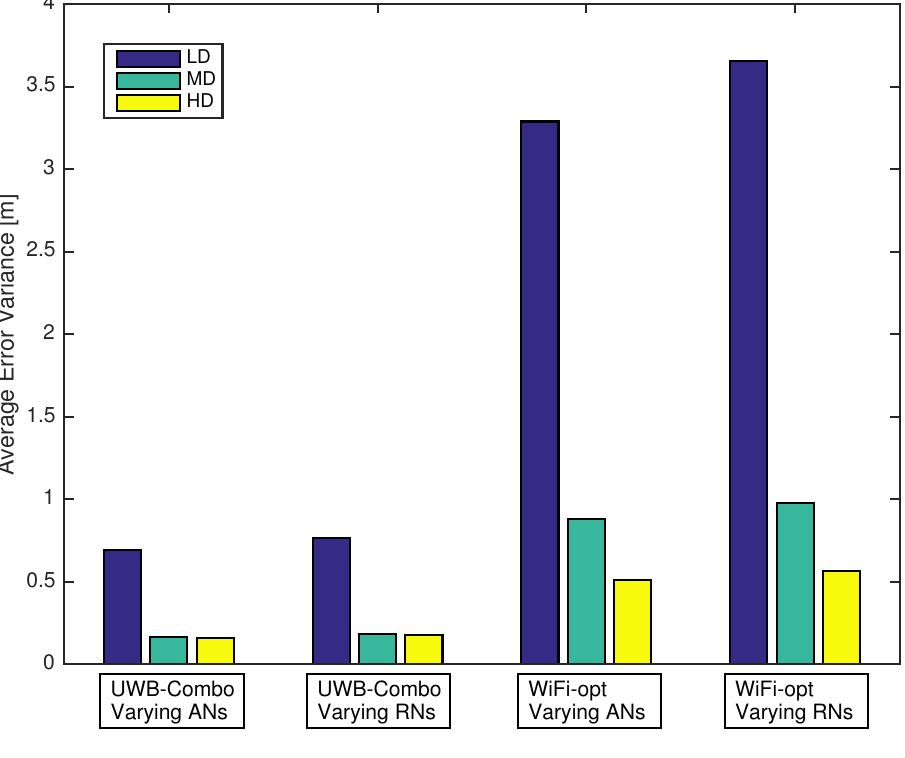
Figure 9. Variance of average positioning error (cid:101) due to topology change in low, medium and high density (LD, MD and HD) scenarios for ultra-wideband (UWB)-combo vs WiFi-opt.